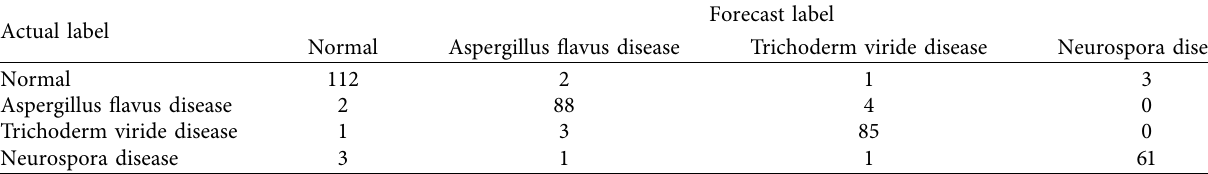
Table 3: Classification confusion matrix.